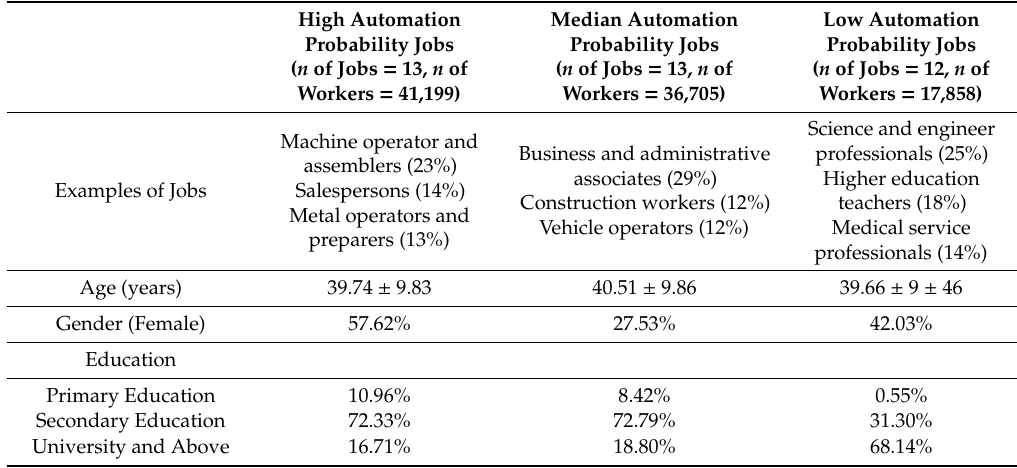
Table 1. Demographic characteristics of employees of high, median, and low automation probability jobs in all six waves of survey ( n =